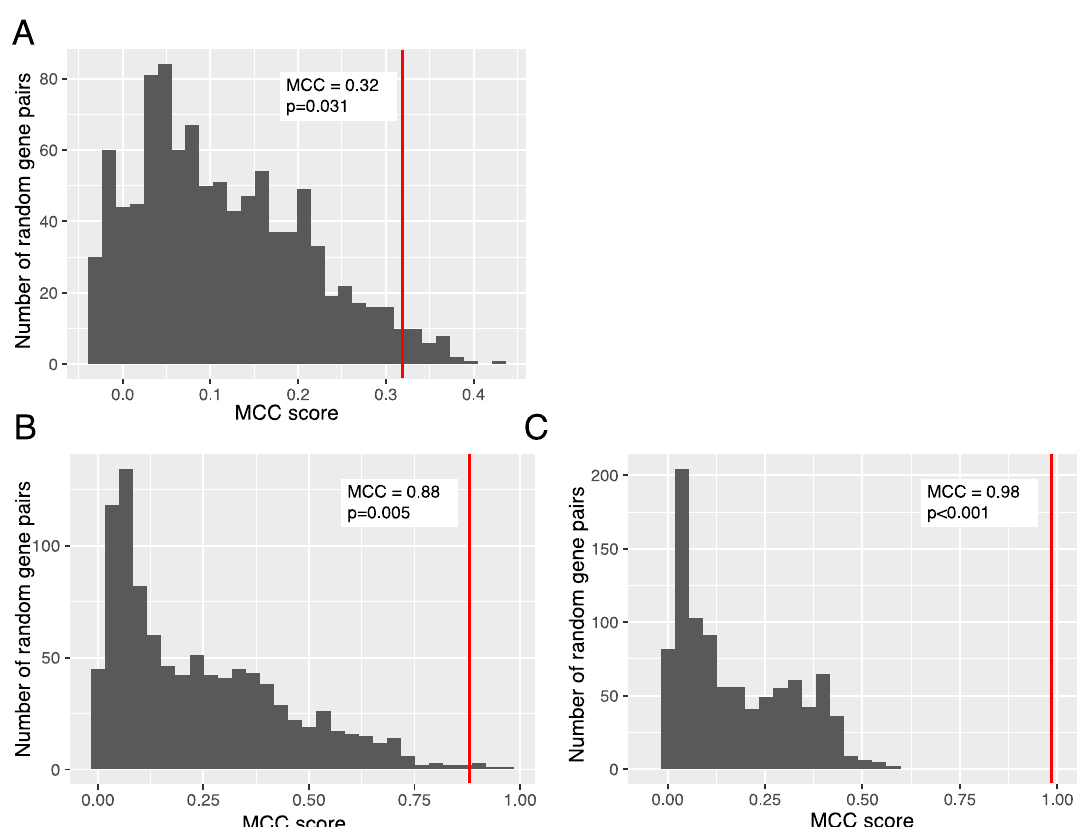
Figure 6. MCC score di ff erence between the GD2 gene signature (sum of log10-transformed expressions of ST8SIA1 and B4GALNT1 ) and 2-gene signatures consisting of randomly selected genes associated with lipid metabolism. ( A ) TNBC and non-TNBC samples from TCGA dataset, n = 981 samples, ( B ) brain tissues and all non-nerve tissue derived samples from GTEx dataset, n = 11491 samples, ( C ) putatively GD2-positive neuroblastoma samples and putatively GD2-negative leukemia samples from TARGET dataset, n = 696 samples.